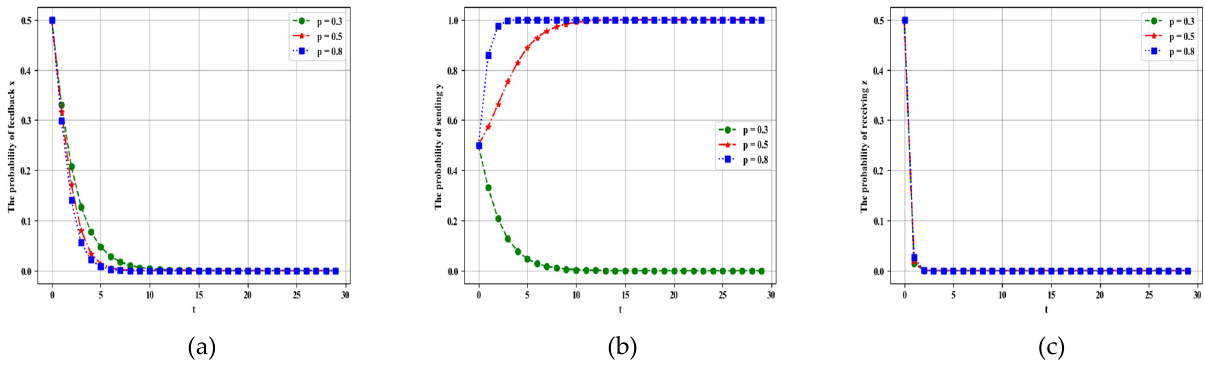
Figure 14. Evolutionary results of 𝑝 shown under different probabilities of strategies 𝑥, 𝑦, and 𝑧 in ( a ), ( b ), and ( c ), respectively.